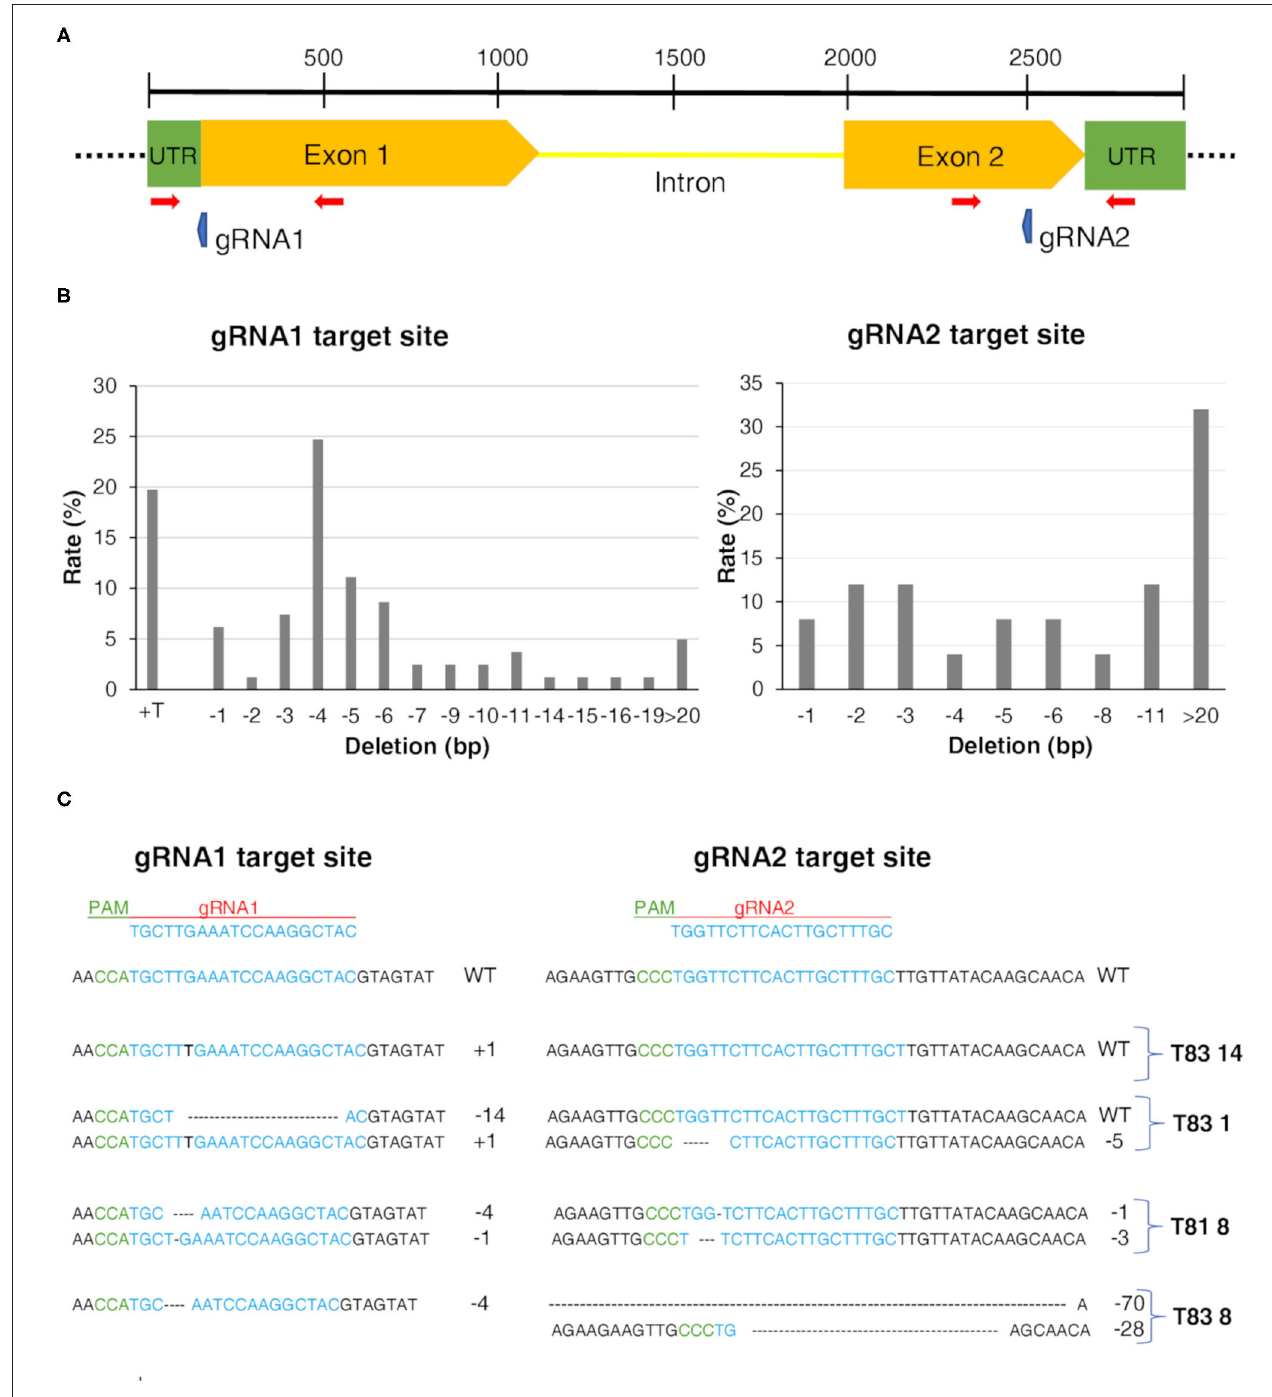
FIGURE 2 | CRISPR/Cas9-editing in Medicago truncatula . (A) Gene structure of CYP93E2 with target sites of CRISPR/Cas9 gRNAs (blue arrows) designed in the first and second exon. The red arrows represent primers used to screen mutations. (B) Rate of mutation sizes. Percentages were calculated by dividing the number of events of each mutation size by the sum of total mutation events. (C) Representation of mutation events generated by the CRISPR/Cas9 system in CYP93E2 gene of the four selected plant lines. Mutations were detected using as reference the control plant lines. The CYP93E2 target sequences are colored in blue. Within the sequence alignment, deletions are represented by traits; insertions are shown with black bold letters. Mutation size and plant line ID are shown on the right. Guide RNA (gRNA) and protospacer adjacent motif (PAM) are indicated in red and green, respectively.